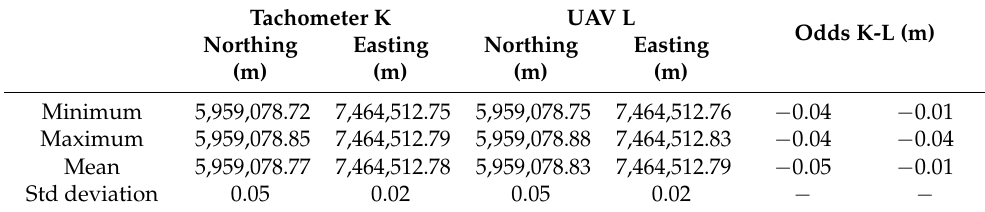
Table 3. Statistics for measured coordinates (altitude H = 10